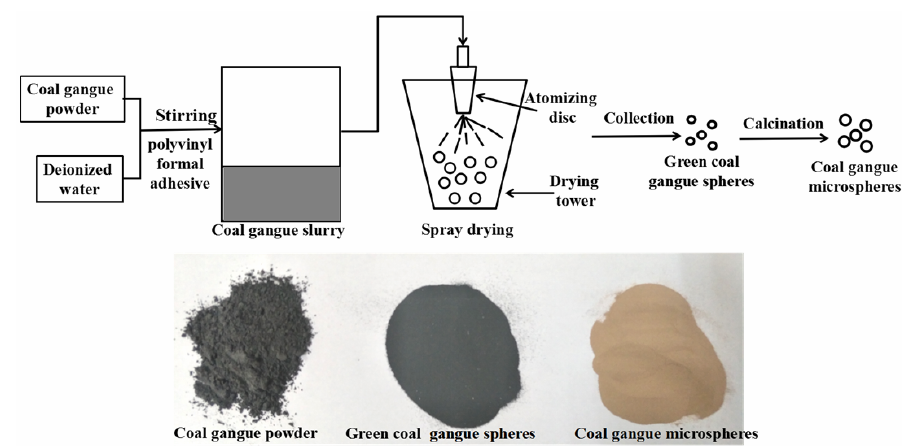
Fig. 1 Scheme of the preparation of coal gangue microspheres.